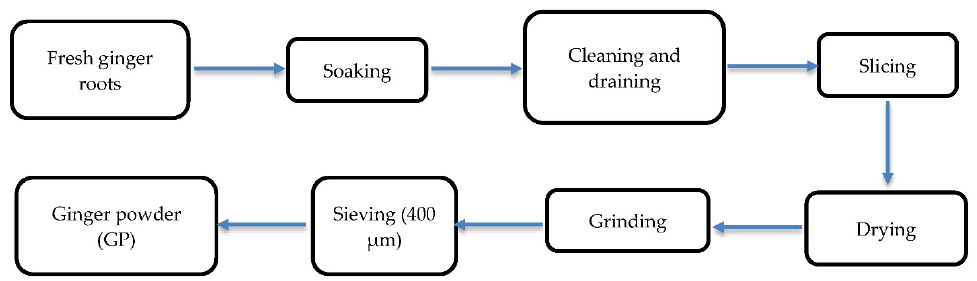
Figure 3. The schematic diagram of making the ginger powder (Source: Sekwati-Monang [30]).